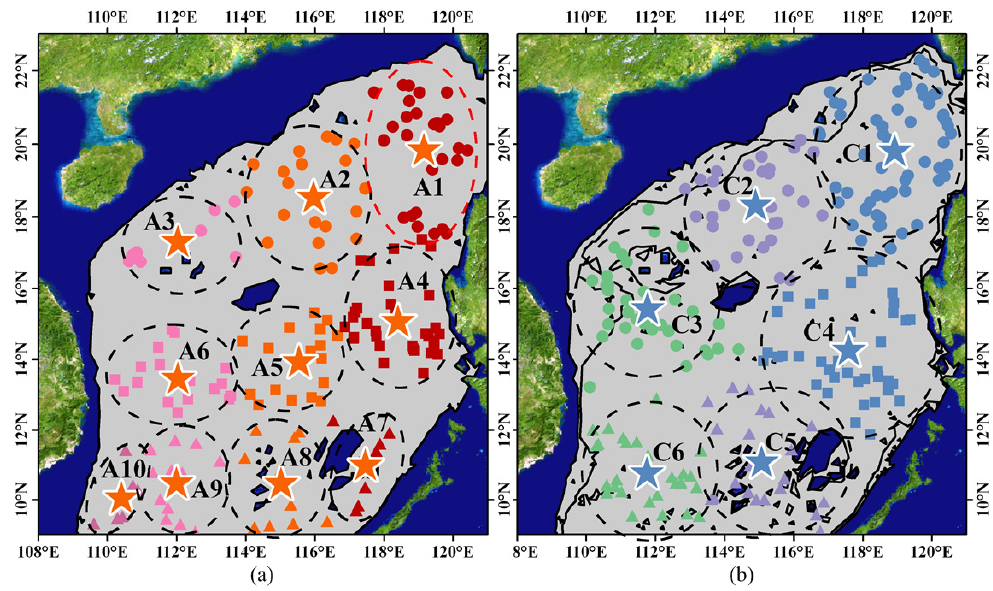
Fig. 6. (a) Ten-cluster result for anticyclonic eddies. Orange stars are cluster centroids. Black dashed lines outline approximate area of clusters. Different groups are distinguished by different colors or symbols. (b) Six-cluster result for cyclonic eddies. Blue stars are cluster centroids. Black dashed lines show approximate area of clusters. Different groups are distinguished by different colors or